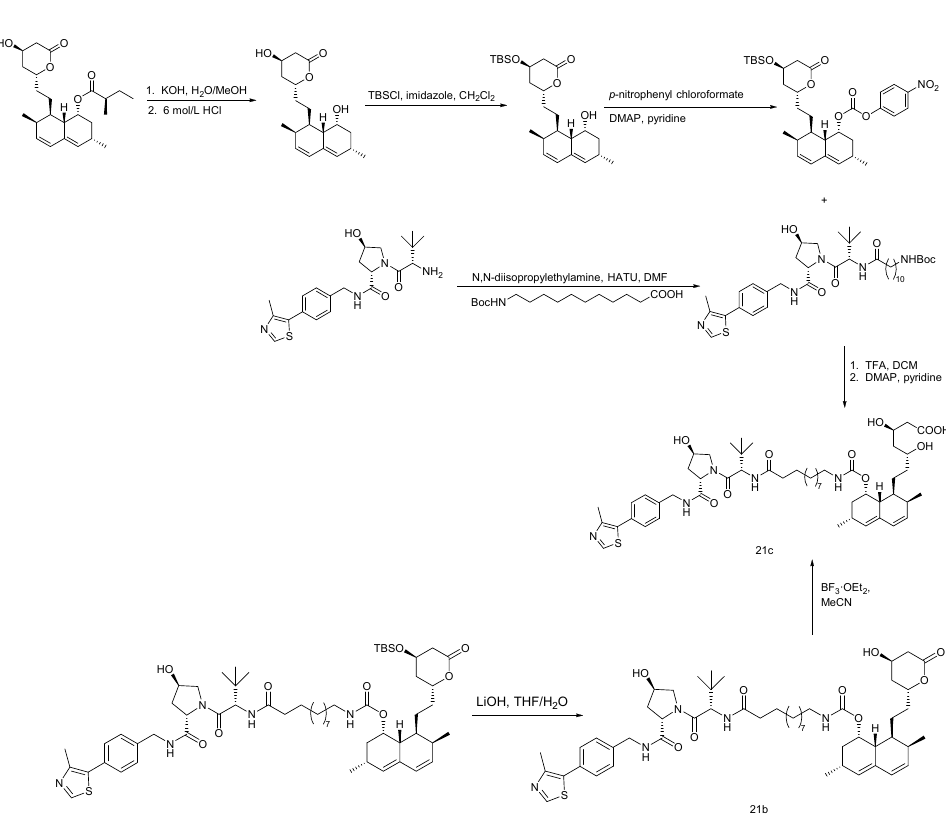
Scheme 15. Synthesis of ovalicin–based PROTAC.